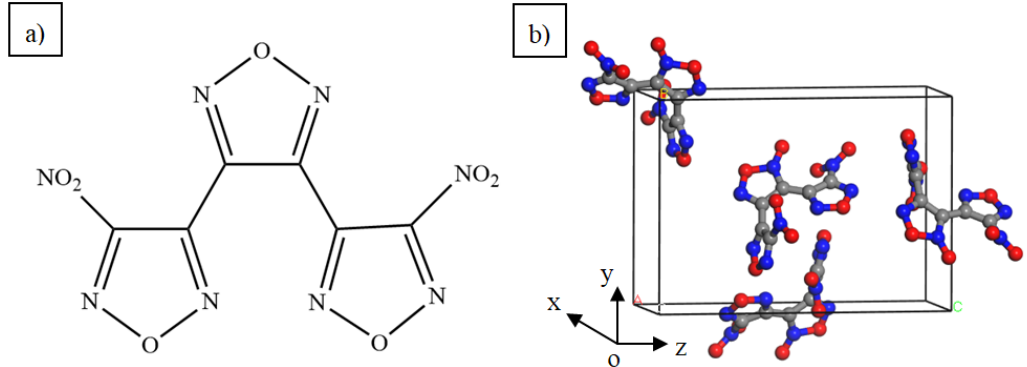
Figure 1. The structure of DNTF. ( a ) The chemical structure; ( b ) The crystal